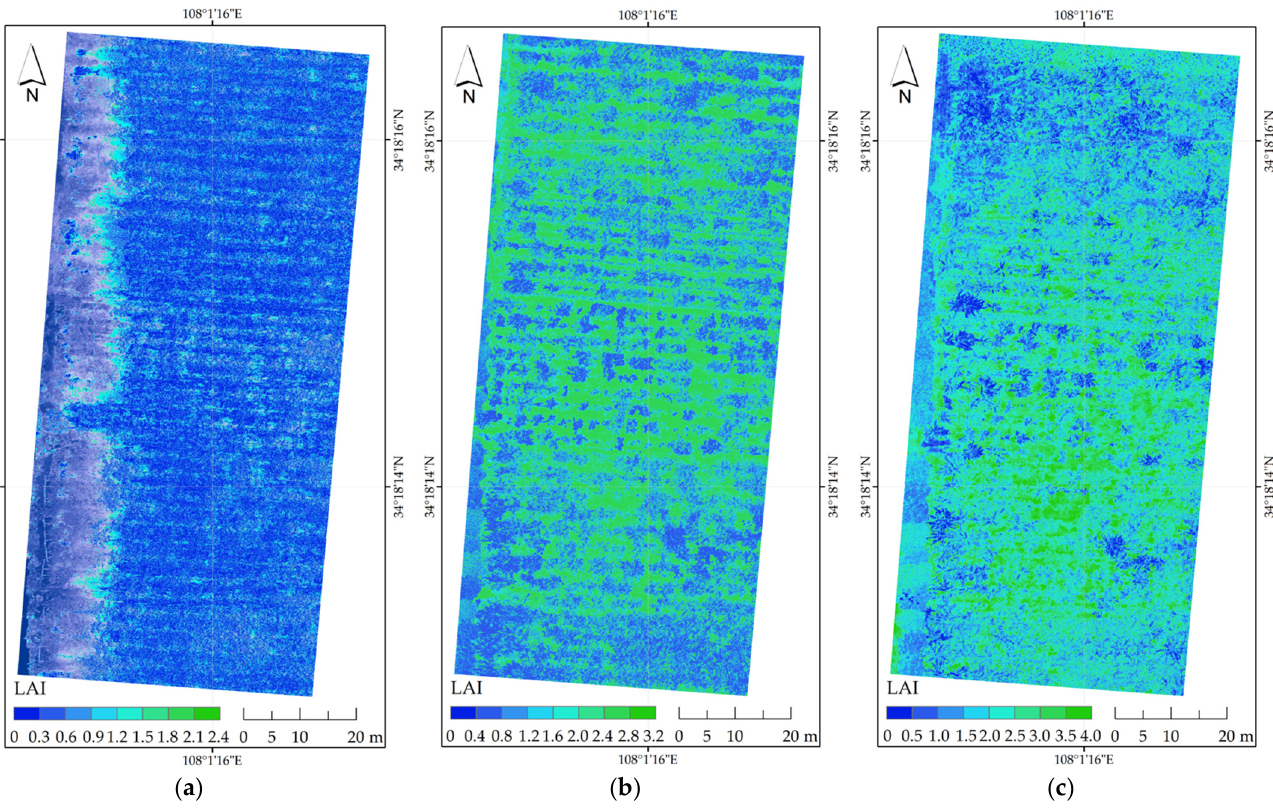
Figure 8. Spatial distribution of kiwifruit LAI estimation in study area. ( a ) Initial flowering stage (IF); ( b ) young fruit stage (YF); ( c ) fruit enlargement stage (FE).